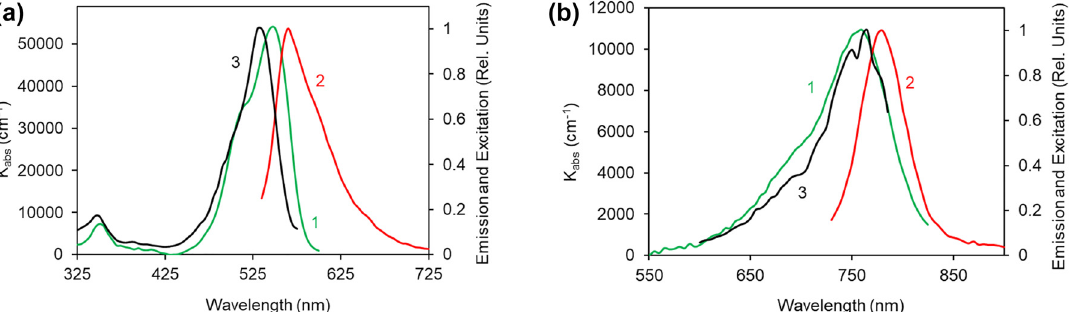
Figure 1: Absorption, emission, and excitation spectra on top of glass. (a) Absorption (trace 1, dye concentration n = 128 g/L), emission (trace 2, n = 128 g/L), and excitation (trace 3, n = 16 g/L) spectra of Rh590:PMMA. (b) Same for HITC:PMMA (trace 1: n = 30 g/L; trace 2: n = 20 g/L; trace 3: n = 30 g/L). (Here and below, the dye concentrations are given for dry polymer, when all solvent evaporated).